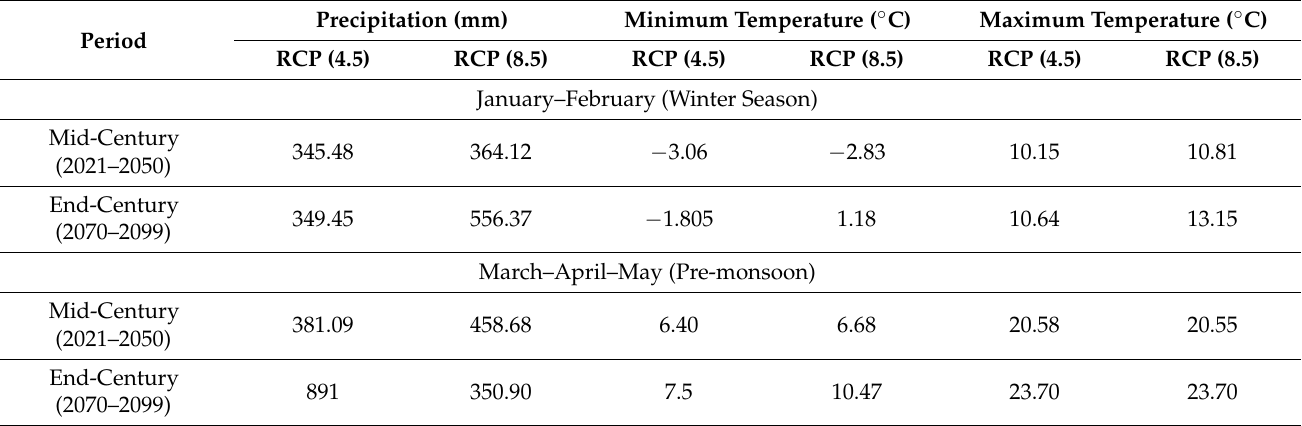
Table 2. Projected seasonal mean precipitation and